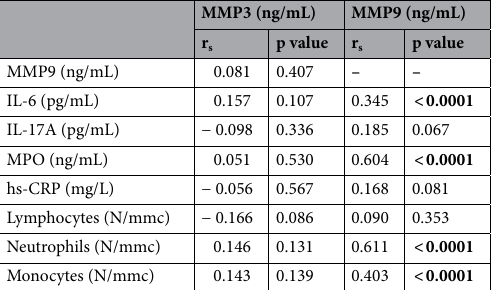
Table 3. Correlations between serum MMPs and inflammation parameters in COVID-19 patients at admission. r s : rho di Spearman. Significant values are reported in bold. hs-CRP high sensitivity C-reactive protein, IL interleukin, MPO myeloperoxidase.